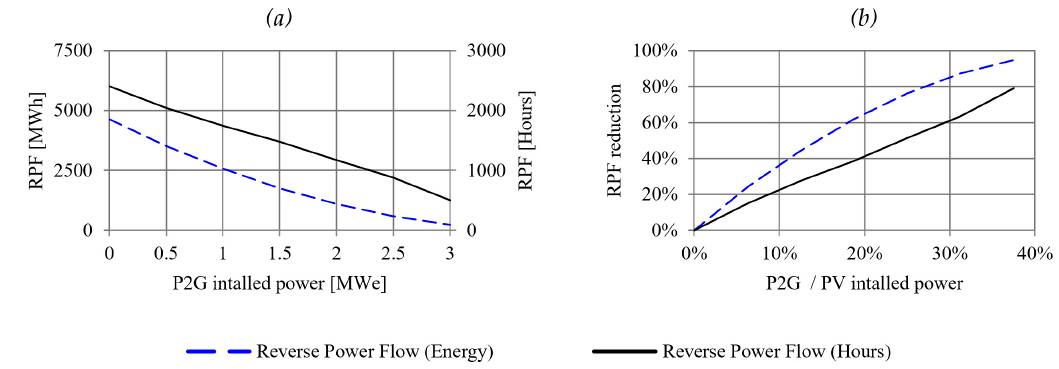
Figure 10. Reverse Power Flow as a function of the installed P2G power ( a ). Reverse Power Flow percentage reduction as a function of the P2G and PV installed power ratio ( b ).